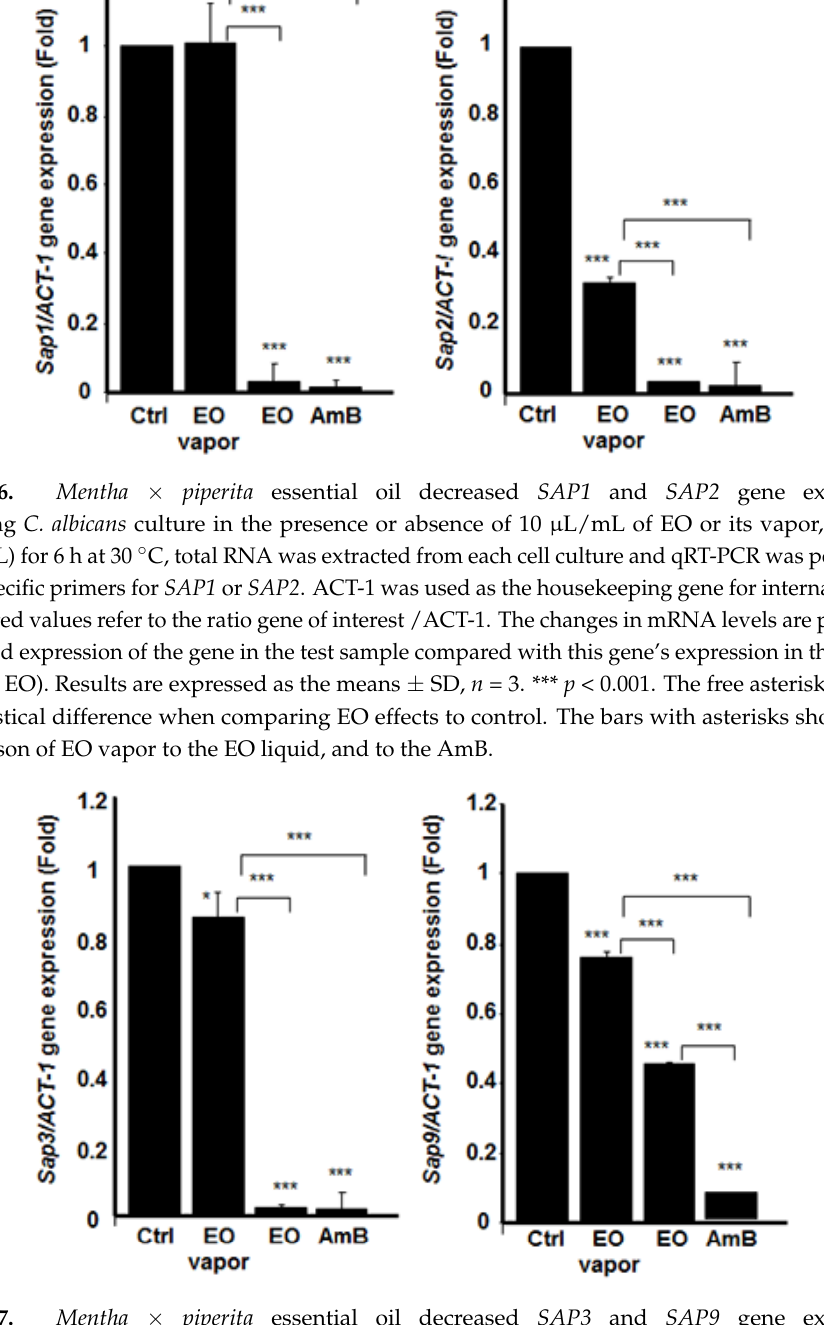
Figure 8. Mentha × piperita essential oil decreased SAP10 and HWP1 gene expression. Following C. albicans culture in the presence or absence of 10 μL/mL of EO or its vapor, or AmB (1 μg/mL ) for 6 h at 30 °C, total RNA was extracted from each cell culture and qRT-PCR was performed using specific